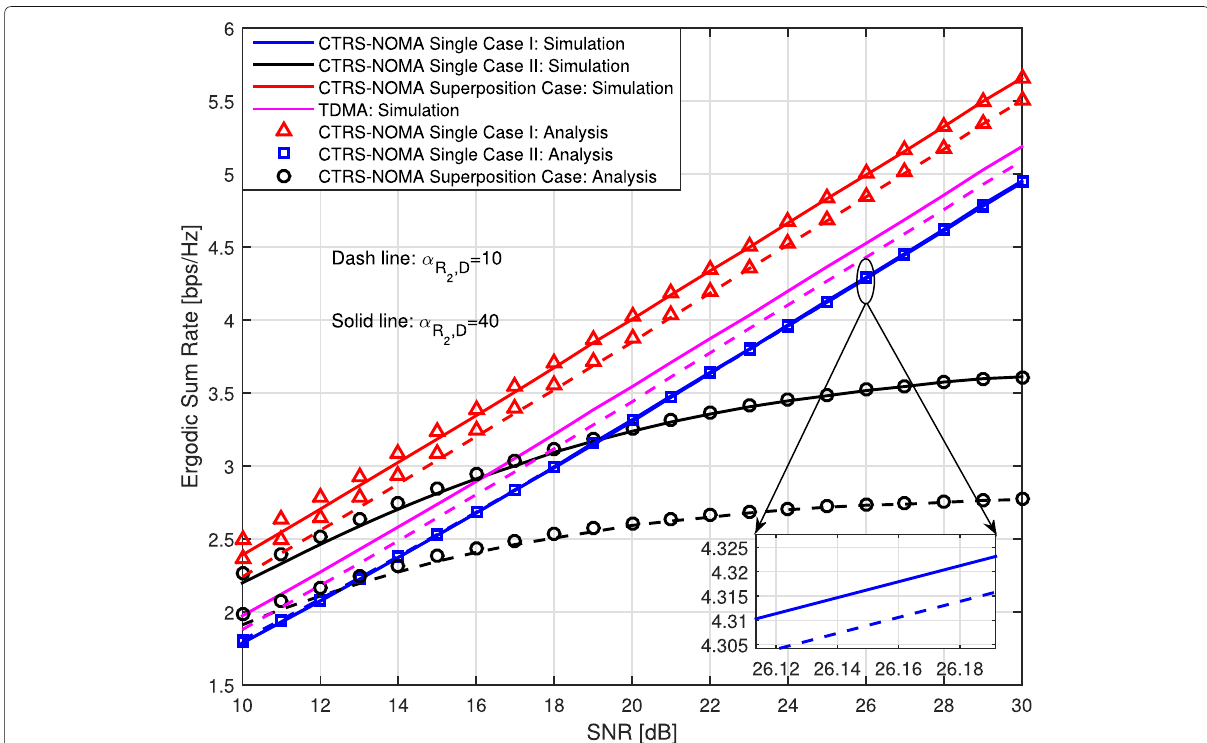
Fig. 4 The ergodic SRs achieved by our proposed CTRS-NOMA single case I, CTRS-NOMA single case II, CTRS-NOMA superposition case, and the TDMA scheme with fixed a 1 = c 1 = 0.7, b 1 = 0.3, α SR